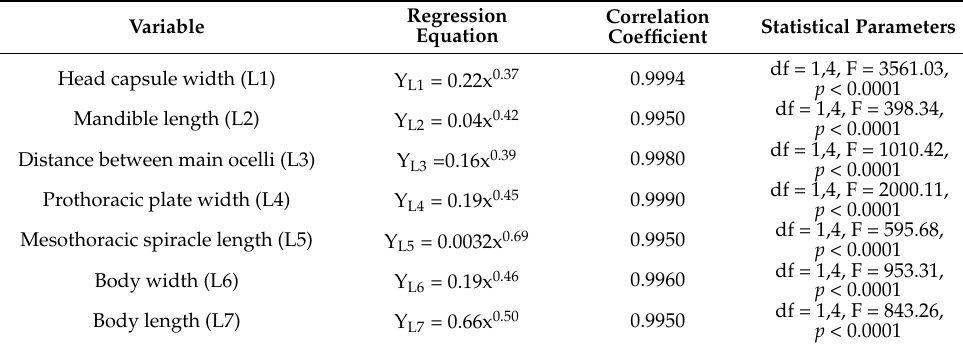
Table 3. Regression relationship between the number of larval instars and variables of Monochamus saltuarius